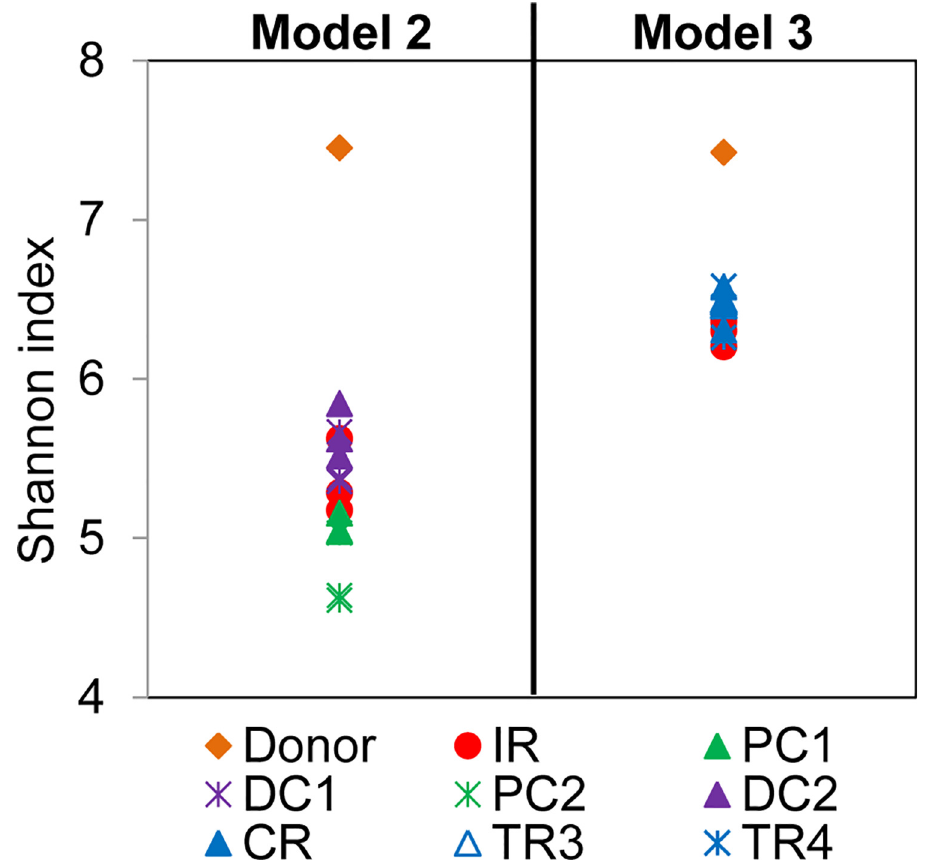
Fig 4. Shannon diversity index of fecal samples and reactors of PolyFermS models. The Shannon index was assessed in fecal donors 2 and 3, all reactors of model 2 and reactors IR, CR, TR3 and TR4 of model 3 of three last days at the end of stabilization phase. A higher Shannon index reflects a more diverse community (in abundance and evenness).